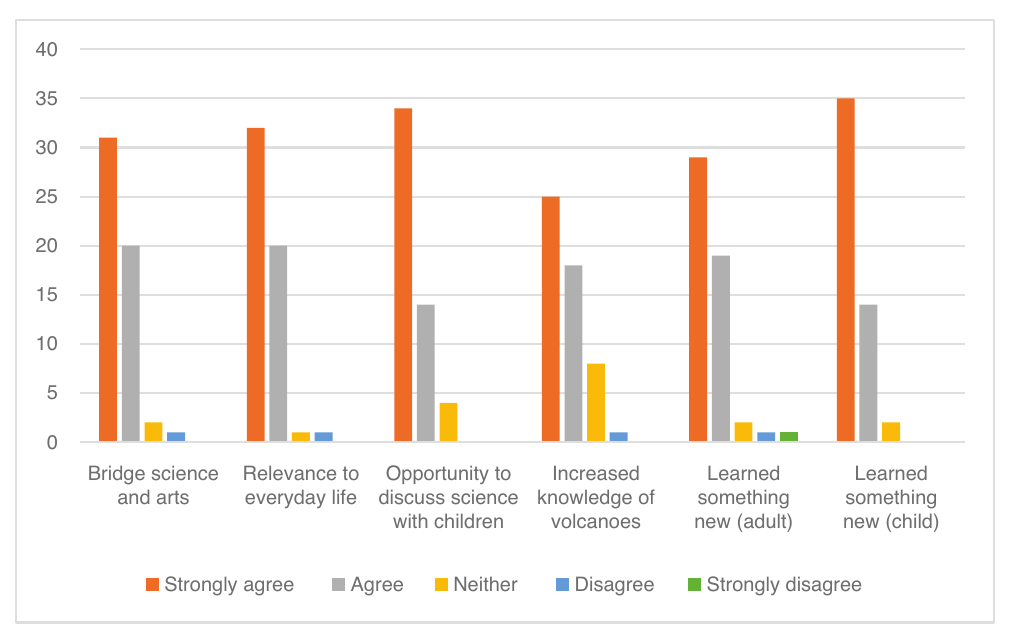
figure 8: Indicators of engagement 2017 (closed ended, n =58) (simons,